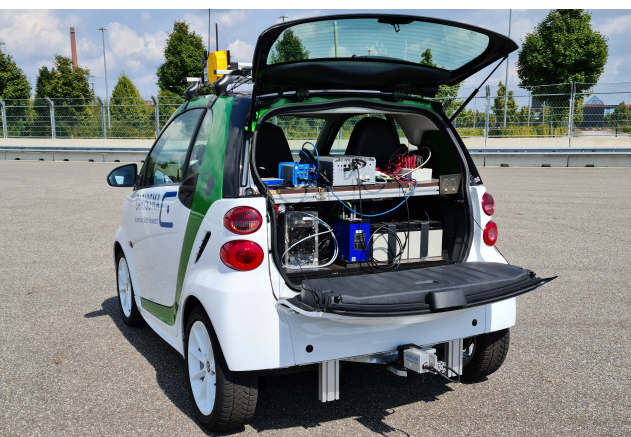
Figure 2. Test vehicle equipped with (1) an ADMA in the trunk (blue), (2) a Correvit sensor on the trailer hitch (gray), (3) a car PC in the trunk (gray), (4) a SatNav receiver on the roof (gray), and (5) a radio antenna for RTK correction data on the roof (black).